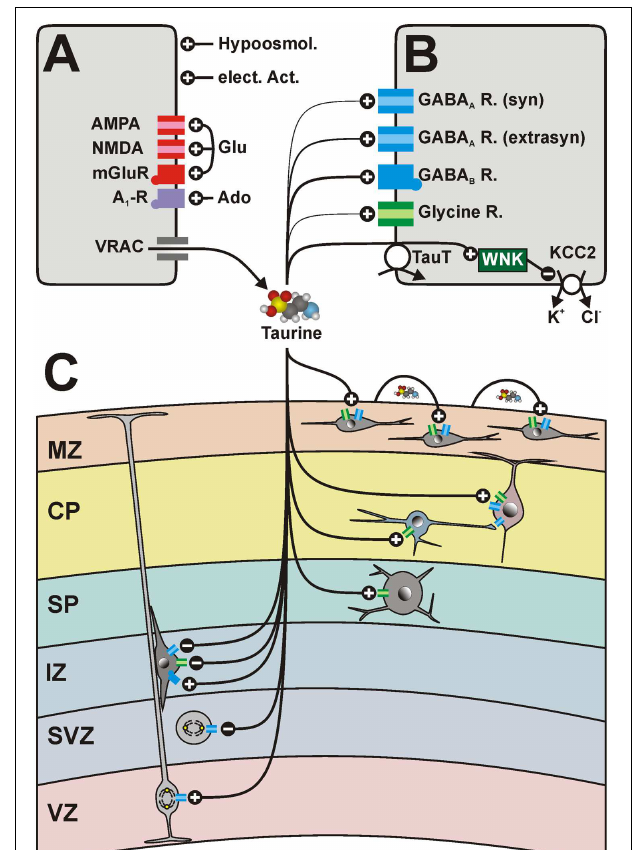
FIGURE 5 | Schematic diagram summarizing the effects of taurine on the immature neocortex. (A) Taurine release is mediated mainly by volume-regulated anion channels (VRAC). The release of taurine is activated by hypoosmotic conditions, electrical activity and via glutamate (Glu), and adenosine (Ado) receptors. (B) Taurine mediates its effects via low-affinity binding to glycine receptors (green symbols) or GABA A receptors (blue symbols) with subunit compositions typical for synaptic receptors. While the taurine affinity to putatively extrasynaptic GABA A receptors is moderate, taurine is a high-affinity ligand for GABA B receptors. In addition, the intracellular taurine concentration, regulated by the TauT, suppresses the function of the Cl − extruder KCC2 via activation of the WNK pathway, thus maintaining depolarizing taurinergic membrane responses. (C) Putative effect of taurine on different cell populations in the developing neocortex. Taurine promotes proliferation in the VZ, but attenuates proliferation in the SVZ. It stimulates chemotaxis via GABA B receptors and suppresses radial migration via GABA A and glycine receptors. Taurine depolarizes SP neurons, pyramidal cell and GABAergic interneurons in the CP, as well as CRc in the MZ via activation of GABA A and/or glycine receptors. The taurinergic depolarization of GABAergic interneurons is in vitro sufficient to generate GABAergic network activity transmitted to pyramidal cells. CRc participate to propagating activity in the MZ mediated by activity-dependent taurine release. See text for